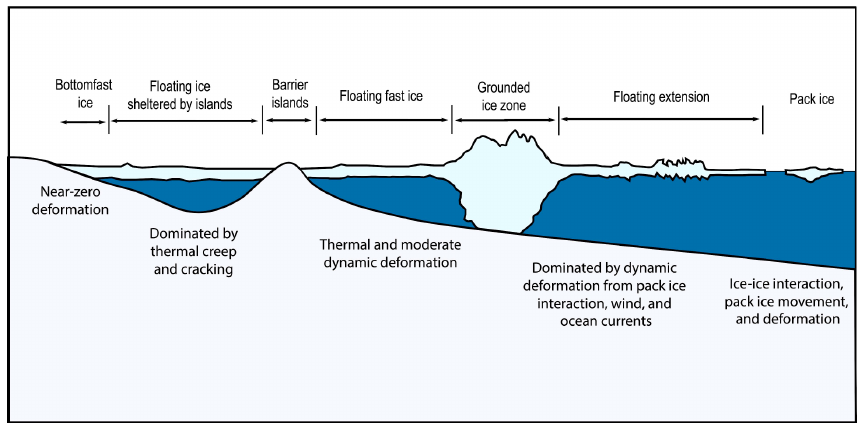
Figure 2. Conceptual scheme of landfast sea ice, where different regimes possess different levels of